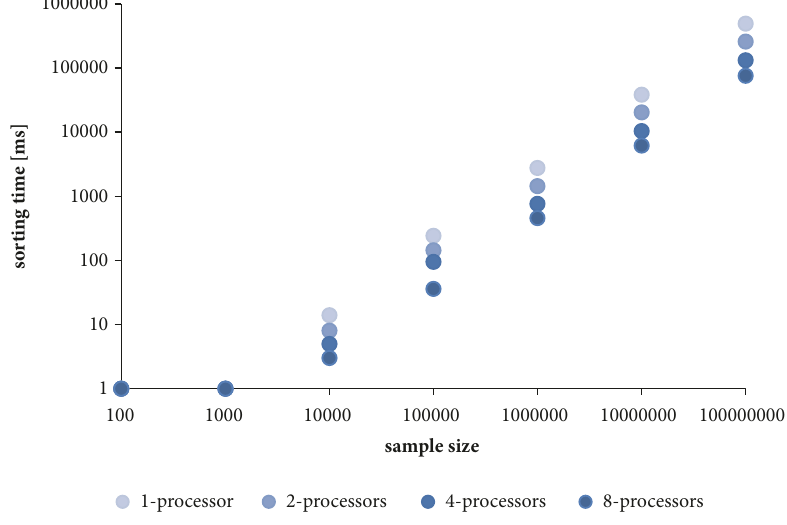
Figure 12: Comparison of benchmark time